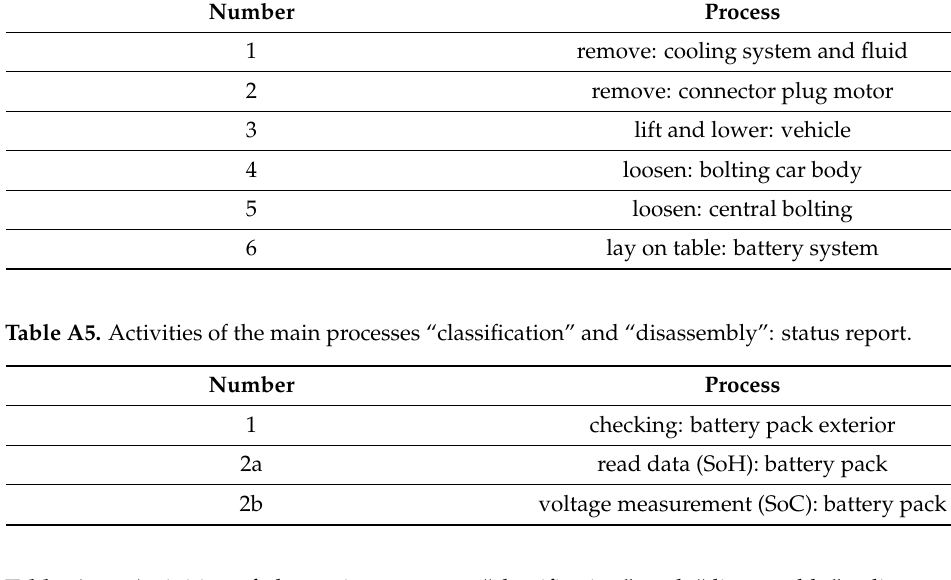
Table A6. Activities of the main processes “classification” and “disassembly”: disassembly periphery